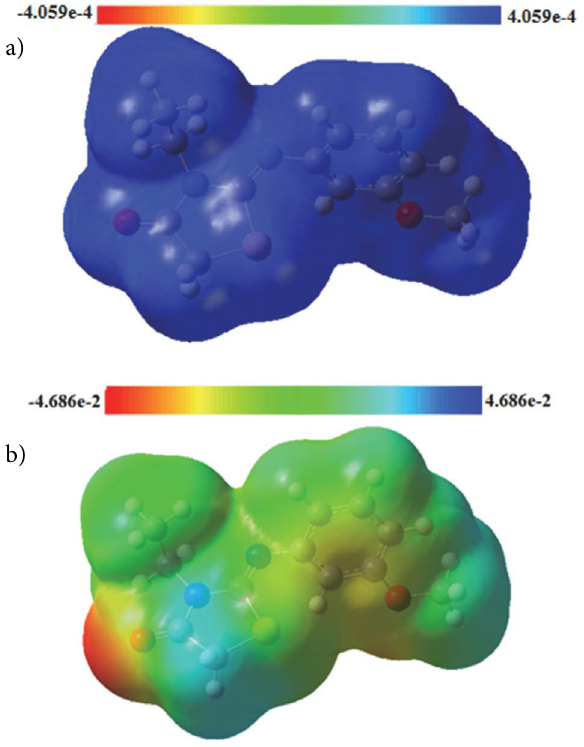
Figure 6. MEP plots for ( Z )-3- N -(ethyl)-2- N ’-((3-methoxyphenyl) imino)thiazolidine-4-one: (a) total electron density, (b) MEP sur- face.